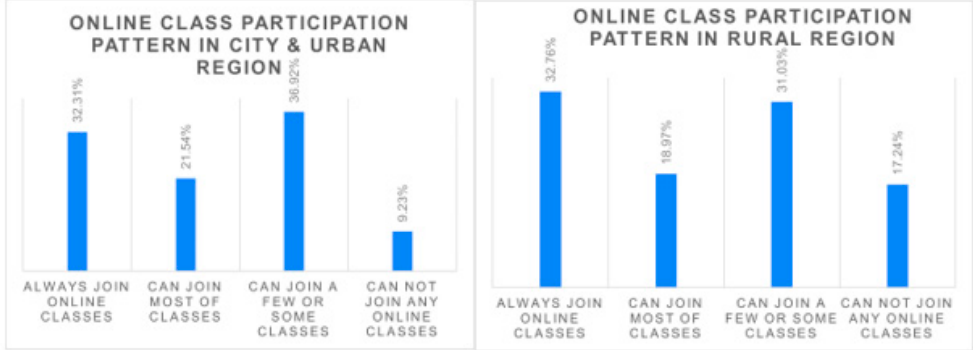
Figure 4. Distribution of students who cannot join any online learning activities based on location.